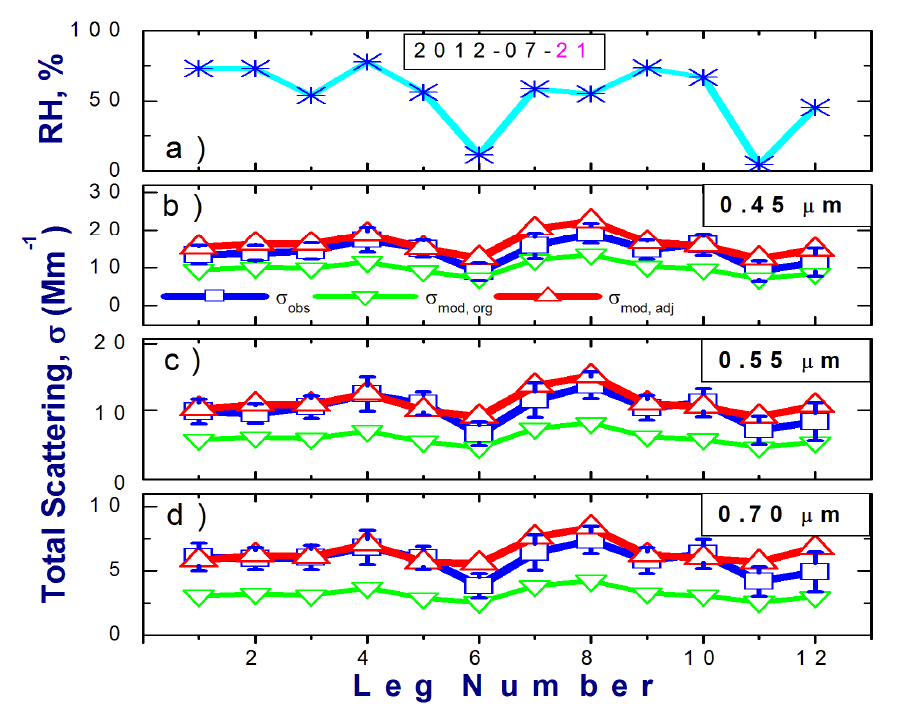
Figure 8. Ambient RH ( a ) and spectral values ( b – d ) of the total scattering coefficient measured (blue) and calculated for the original (green) and RI-based adjusted (red) size distributions for twelve FLs on 21 July 2012 at three wavelengths: (b) 0.45; (c) 0.55 and (d) 0.70 µm. Error bars represent uncertainties of measured scattering